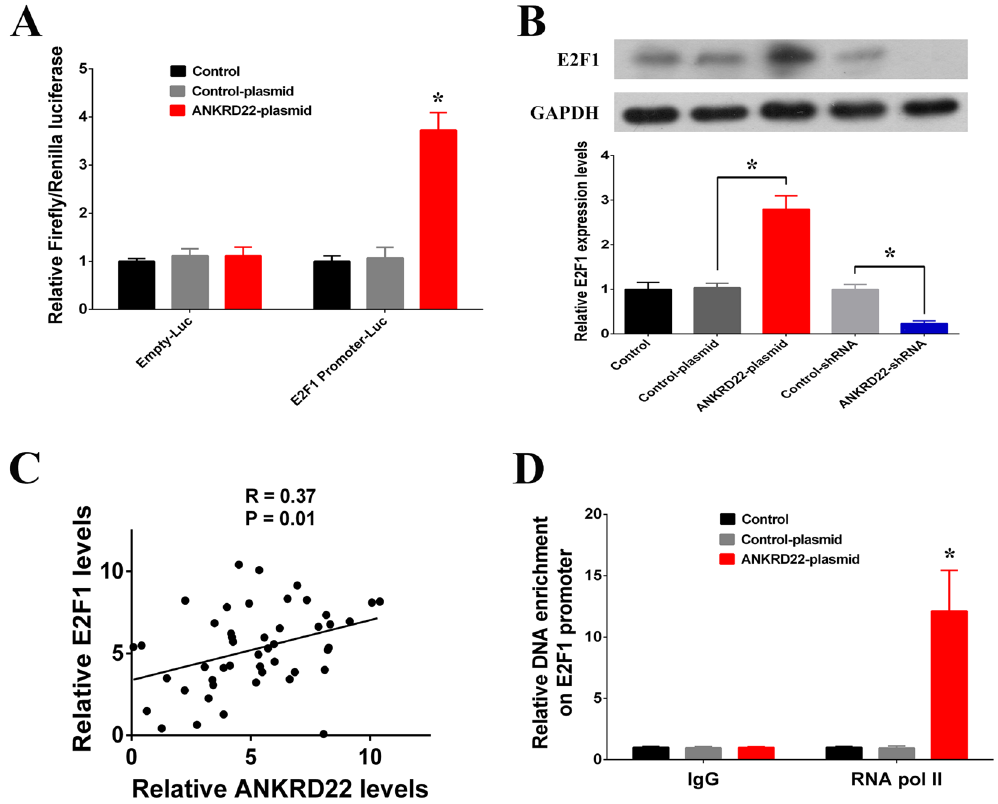
Figure 6. ANKRD22 promoted the expression of E2F1 gene. ( A ) The transcriptional activation of E2F1 by ANKRD22 was detected by luciferase assays. ( B ) Overexpression of ANKRD22 increased and knockdown of ANKRD22 decreased the mRNA and protein expression levels of E2F1 in H1299 cells. Full-length blots are presented in Supplementary Figure S7. ( C ) Correlation between the relative expressions of E2F1 and ANKRD22 in specimens from NSCLC patients expressed using linear regression (solid line). ( D ) RNA polymerase II (RNA Pol II) signal in the E2F1 promoter region was detected by chromatin immunoprecipitation (ChIP) assay. (n = 3, * P <